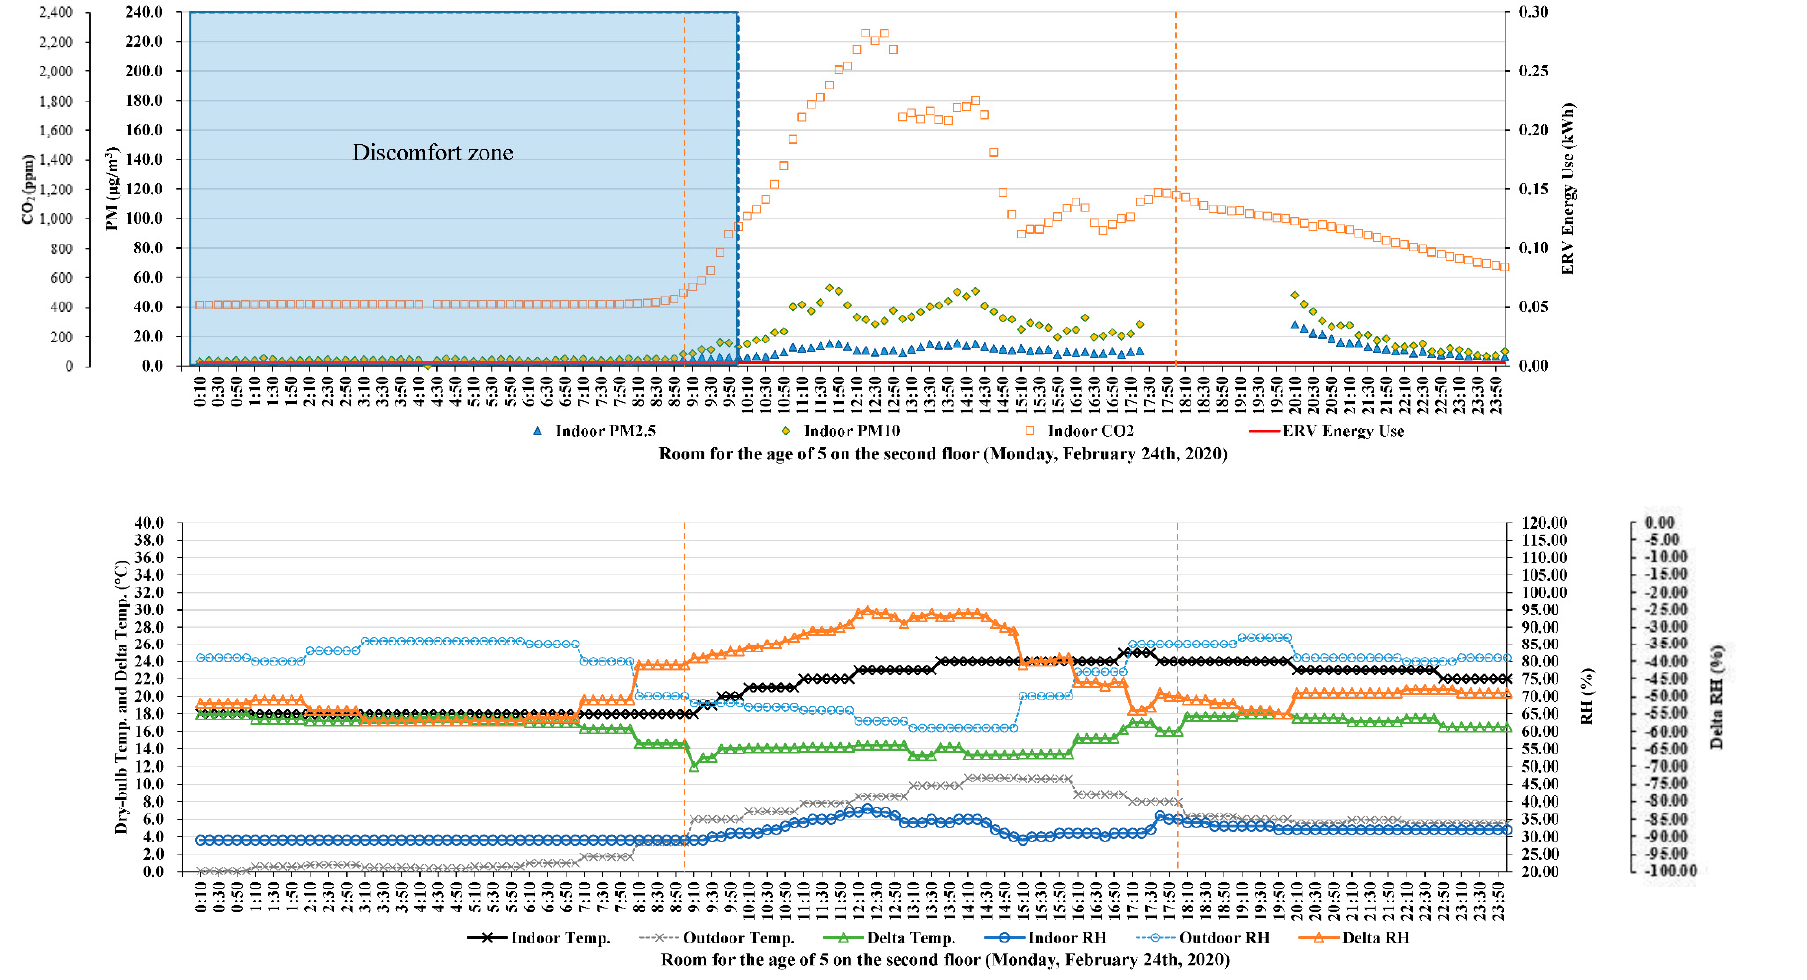
Figure 7. Time-series analysis on the day when the ERV system was off.